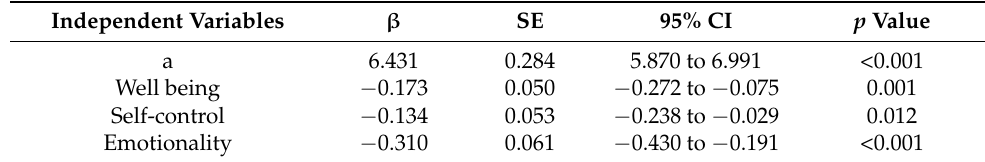
Table 4. Multiple linear regression with the Boredom Proneness Scale (BPS) as a dependent variable and the aspects of the Nurses’ Emotional Intelligence Scale (TEIQue-SF) ( n = 189) as independent variables. Independent Variables β SE 95% CI p Value a 6.431 0.284 5.870 to 6.991 <0.001 Well being − 0.173 0.050 − 0.272 to − 0.075 0.001 Self-control − 0.134 0.053 − 0.238 to − 0.029 0.012 Emotionality − 0.310 0.061 − 0.430 to − 0.191